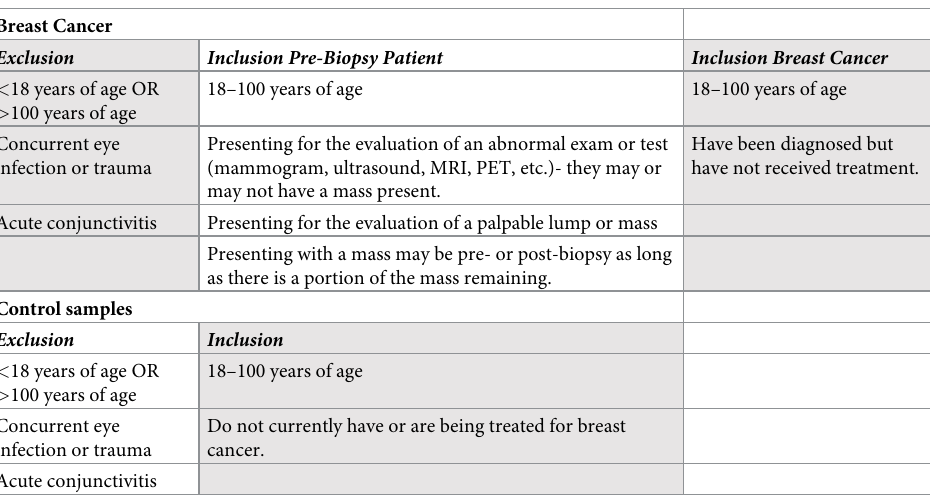
Table 1. Inclusion/Exclusion